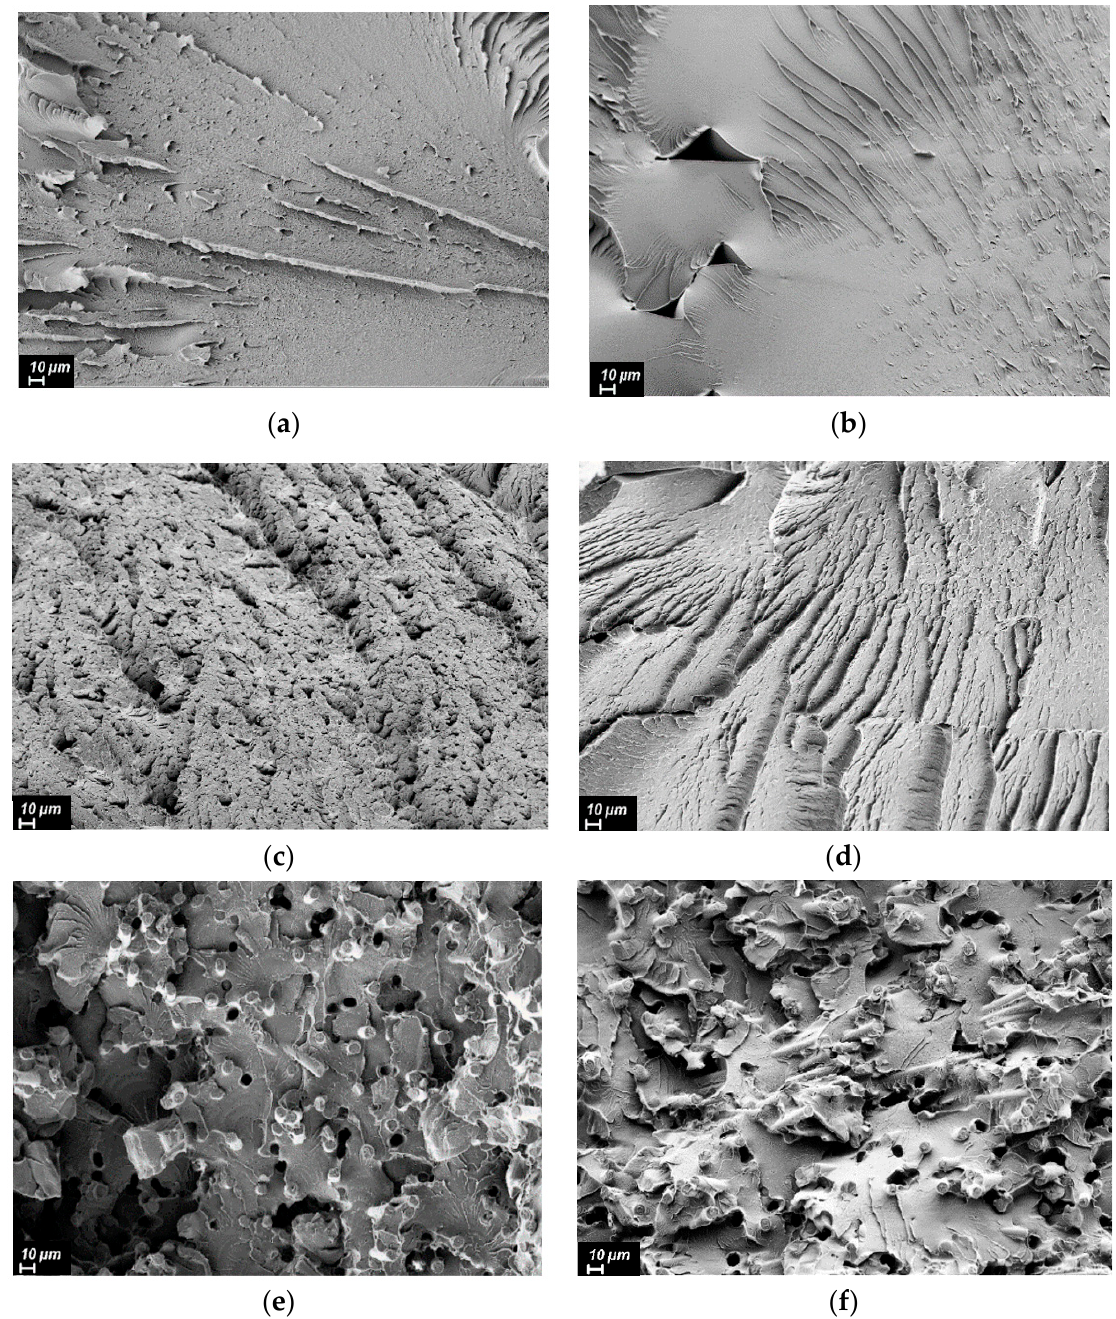
Figure 7. Mechanical characteristics of the FFF samples from R-BAPB and its composites.